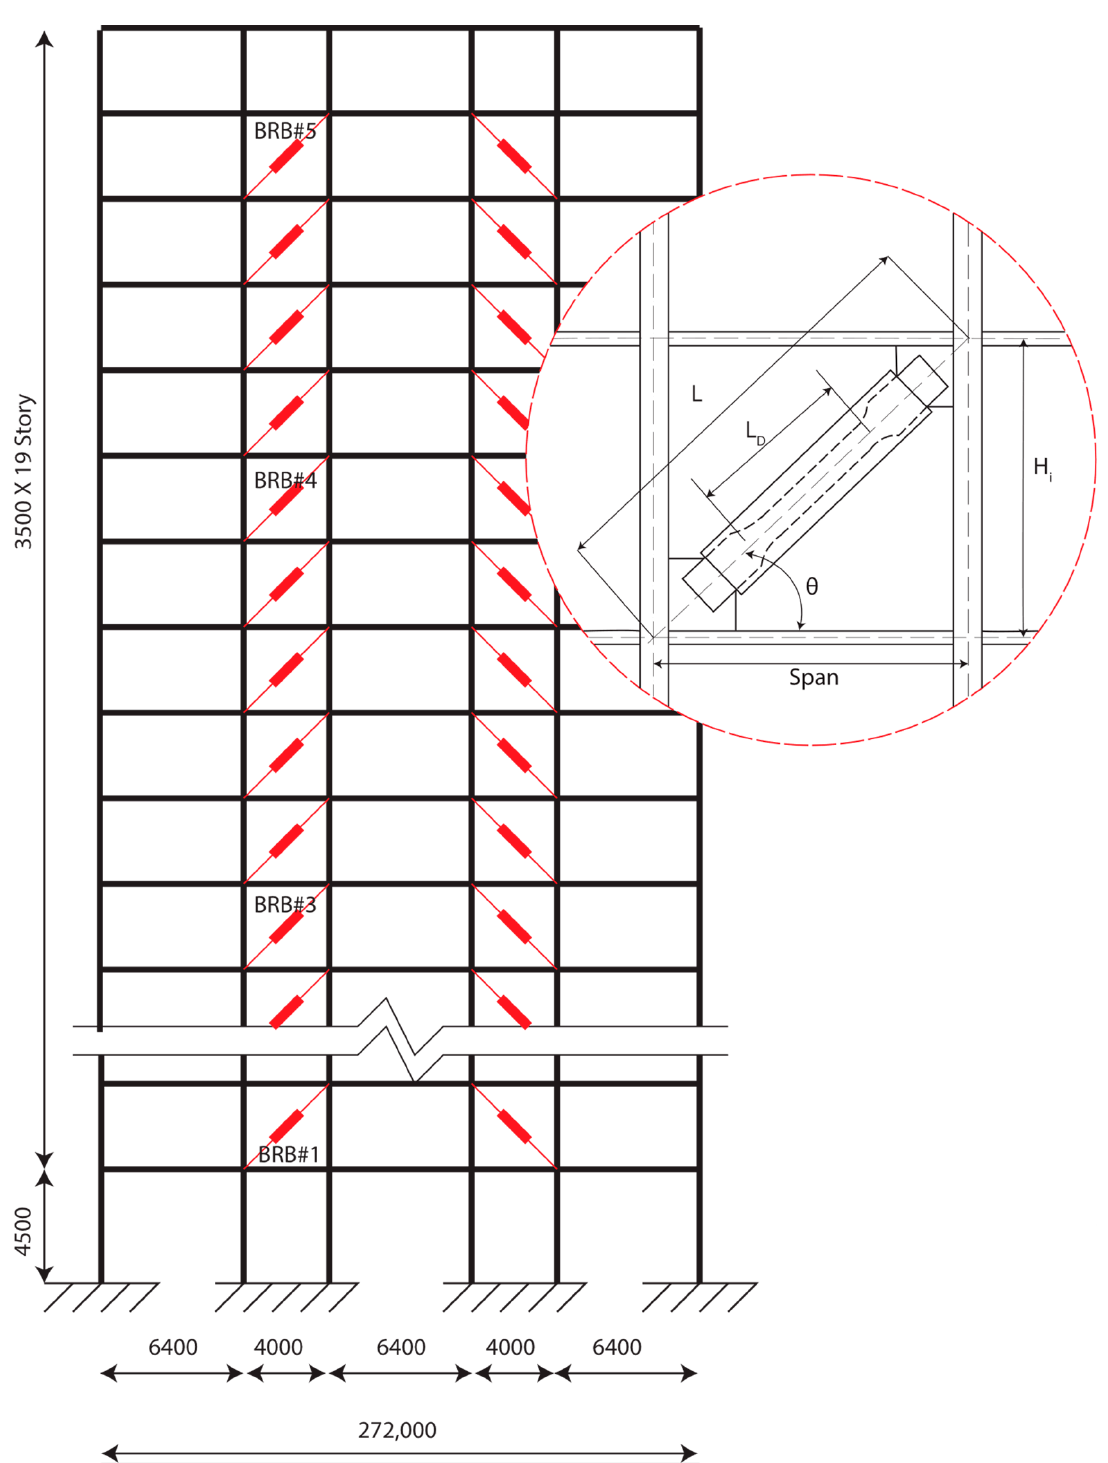
Figure 1. Twenty-story steel prototype building elevation and BRB configuration (dimensions in mm).